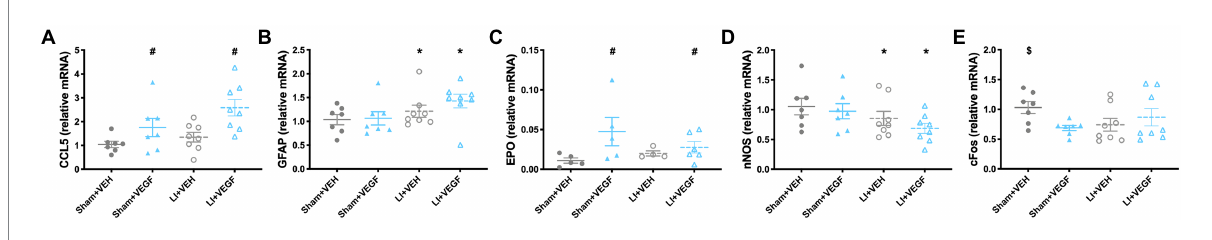
FIGURE 4 Gene expression in the hippocampus of male rats. Gene expressions of CCL5 (A) and EPO (C) were increased in VEGF rats compared with VEH rats. GFAP expression (B) increased and nNOS (D) decreased in LI rats compared with sham rats. The Sham+VEH group had significantly increased cFOS expression (E) compared with the Sham+VEGF group. *, LI rats significantly different than sham rats; #, VEGF treated rats significantly different than VEH treated rats; $, Sham+VEH rats significantly different than Sham+VEGF rats; p < 0.05. n = 7–8 per group. Error bar = SEM.